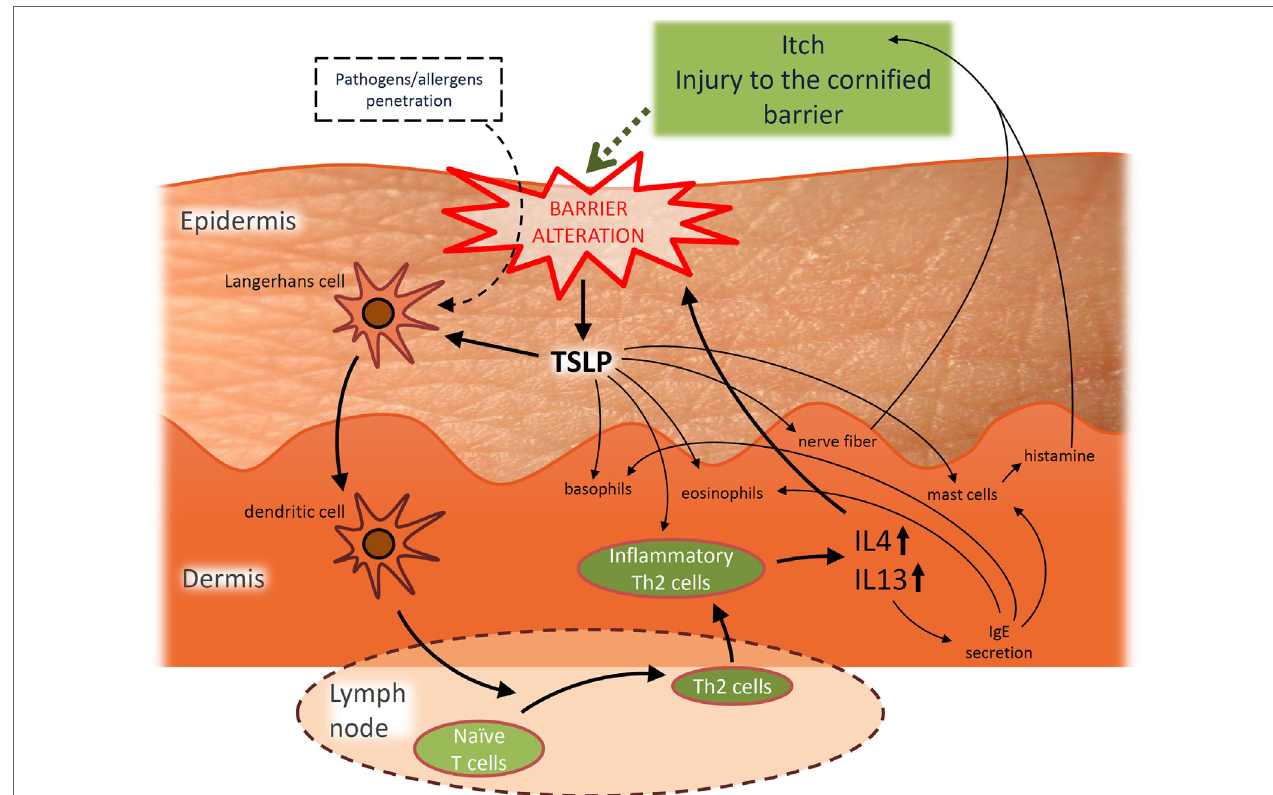
FiGURe 1 | Hypothetic simplified representation of the pivotal role played by thymic stromal lymphopoietin (TSLP) in the pathogenesis of acute atopic dermatitis (AD) and the interplay between barrier alterations and Th2 immune dysregulation. TSLP released from challenged keratinocytes is able to activate migration of Langerhans cells toward draining lymph nodes (35) where they subsequently initiate allergic response by promoting differentiation of naïve CD4 + T cells into inflammatory Th2 effectors. TSLP can also directly act on these Th2 effectors to induce their proliferation (43–45). Th2 effector cells produce IL-4, IL-5, IL-13, TNF α , while downregulating IFN γ (35), possibly explaining the link observed between barrier alterations and inflammatory conditions. Indeed, among these cytokines, IL-4 and IL-13 are more particularly known as being able to alter the expression of proteins involved in the epidermal barrier like filaggrin (19, 20, 49), loricrin (LOR) and involucrin (IVL) (50), desmoglein 1 and 3 (component of desmosomes) (49, 51), sphingomyelinase and glucocerebrosidase (genes implicated in the synthesis of ceramides) (52), or the tight junction component claudin-1 (53). Every cytokine-induced alteration of the epidermal barrier allows conditions more favorable for penetration of allergens/pathogens that can then be recognized by dendritic antigen-presenting cells. Processed allergens/pathogens are next presented to naive B cells and activate them to eventually produce specific immunoglobulin E (IgE). Such IgE then bind to the high affinity receptor Fc ε RI expressed on basophils, eosinophils, and mast cells. After re-exposure to a previously encountered antigen, the body can respond directly and more strongly. Indeed, when IgE are produced in greater amounts, basophils, eosinophils, and mast cells are ready to mediate inflammatory reactions. This immune inflammatory response is known as the allergic response. Basophils are able to promote Th2 cytokine response, while mast cells can massively degranulate, notably releasing histamine which induces edema and pruritus. IL-4 is known to modulate this allergic response and to induce overproduction of IgE. In addition, TSLP could also play a role in the itch symptoms observed in AD patients. Indeed, TSLP activates mast cells to release histamine upon binding to its specific receptor. Even further, keratinocytes directly interact with dermal sensory neurons via TSLP, thereby inducing itch (42). Moreover, TSLP may also promote basophil and eosinophil responses. Basophils promote Th2 cytokine response, while TSLP induces recruitment of eosinophils to Th2 cytokine-associated inflammation sites